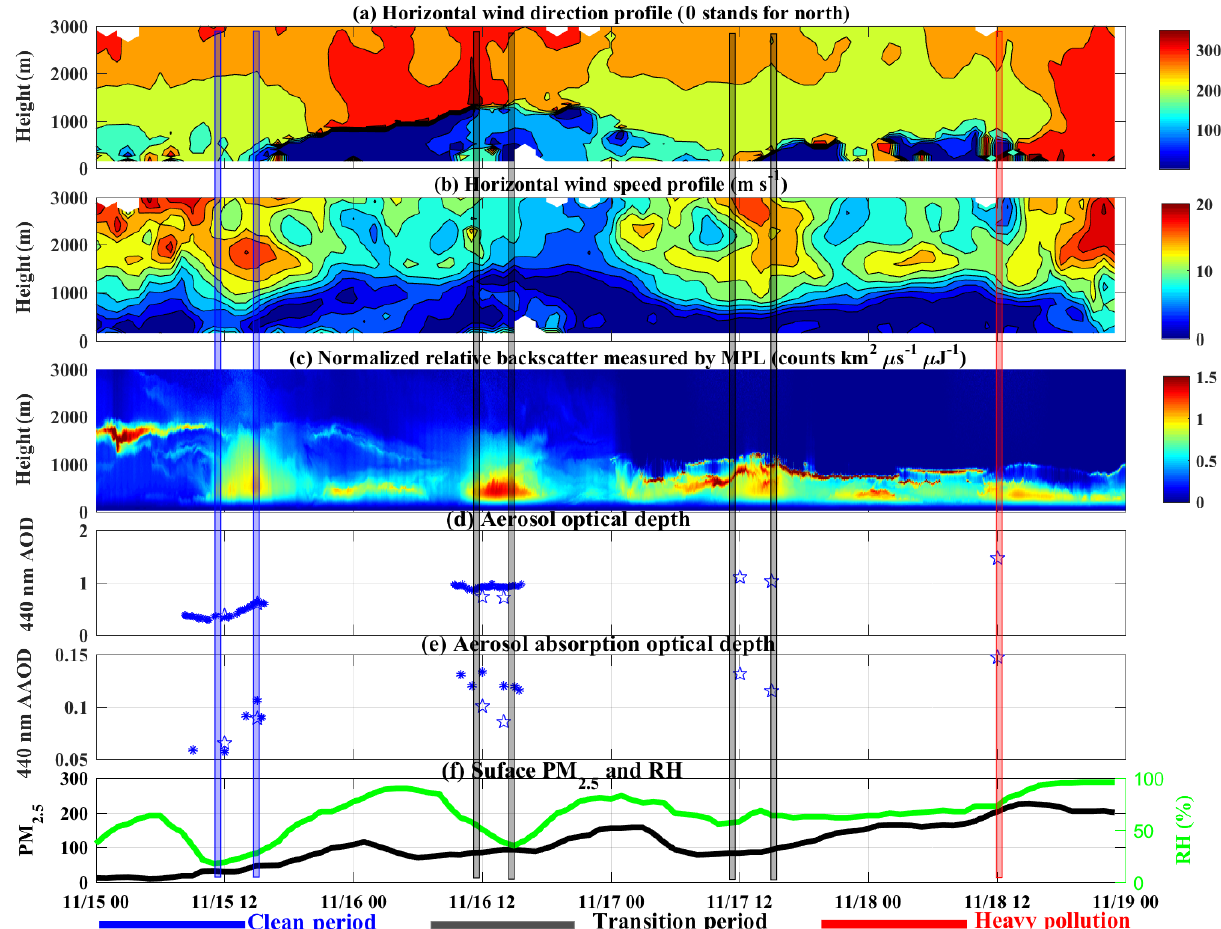
Figure 1. Temporal variations from 15 to 18 November in vertical profiles of wind direction (a) and wind speed (b) measured by wind profile radar. (c) Particle extinction measured by MPL. Aerosol optical depth (d) and aerosol absorption optical depth (e) from AERONET (asterisk) and derived from aircraft in situ measurements (open star). (f) Surface PM 2 . 5 and RH. The vertical bars denote the periods of flight profiles, with blue, black and red representing the clean period, transition period and heavy pollution period during a pollution event, respectively. The other two pollution events are shown in the Supplement Figs. S2 and